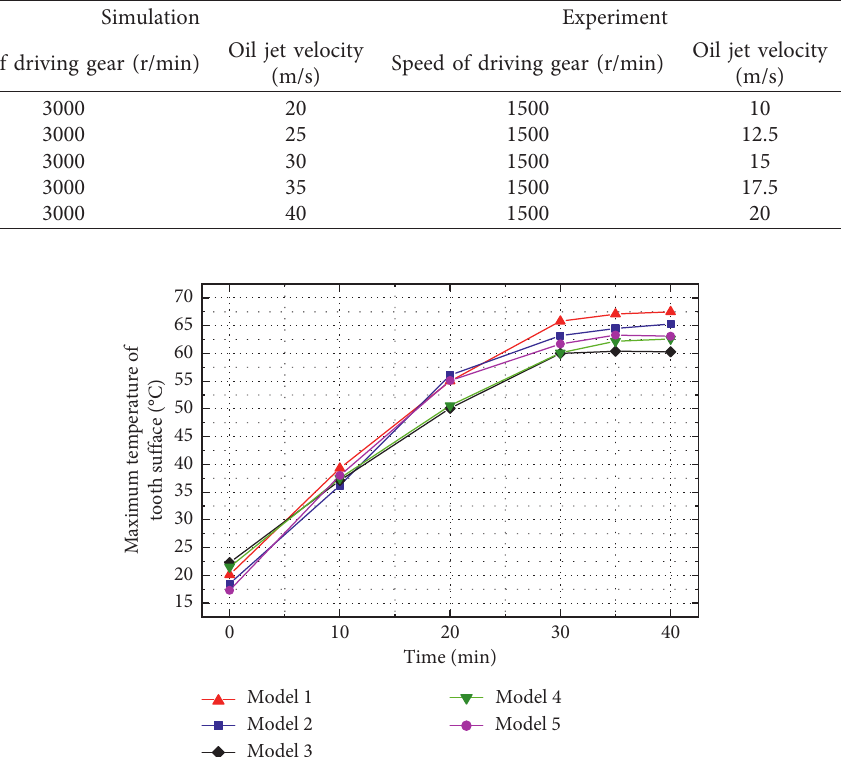
Table 5: Experimental parameters.